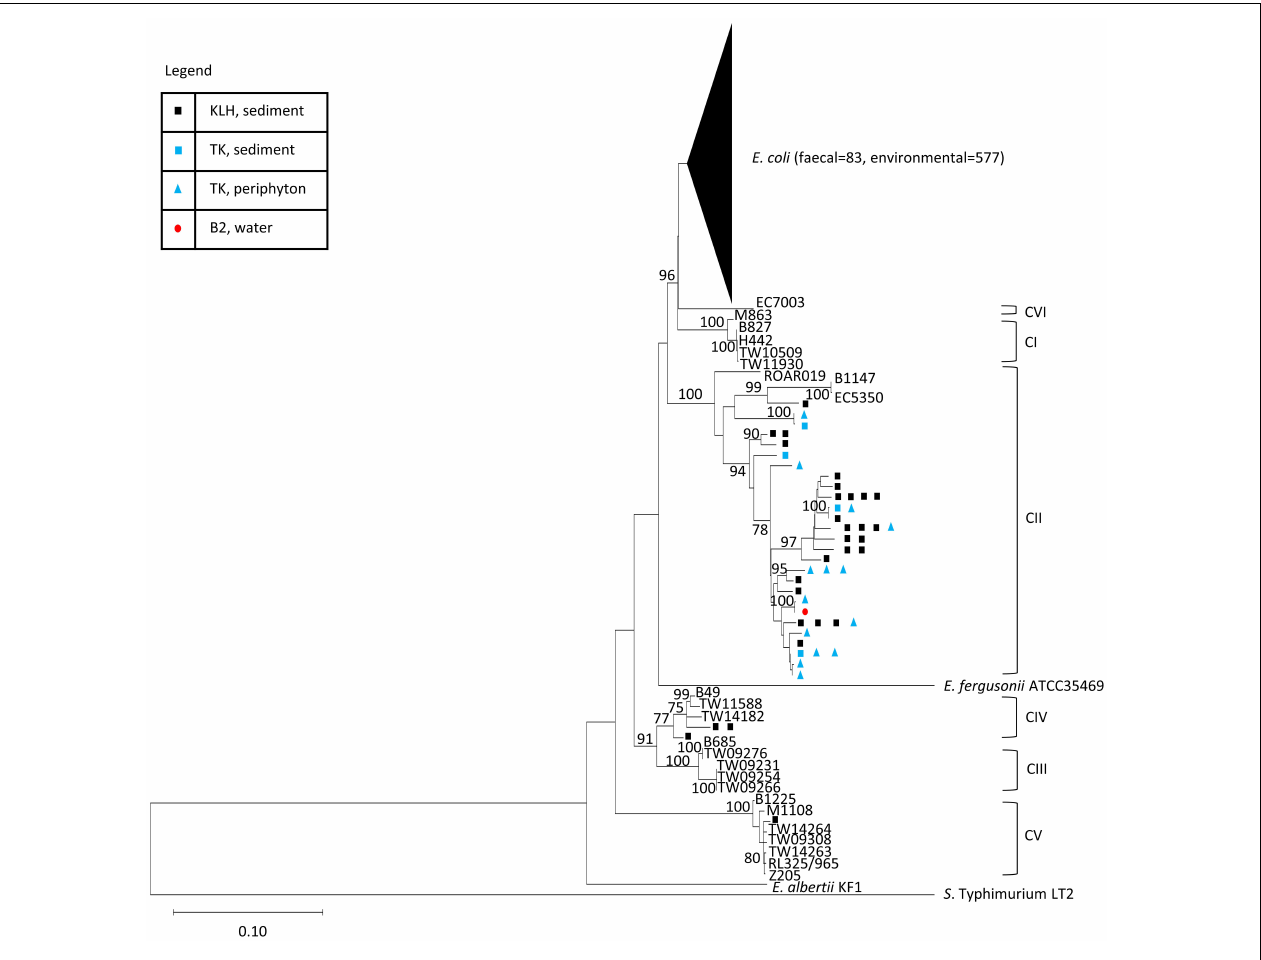
FIGURE 1 | Phylogenetic position of the isolates in study in reference to strains of Escherichia spp. reported in previous studies. ML tree was built using concatenated sequences of seven MLST loci from the isolates and reference strains (general time reversible G + I model, 500 bootstrap replications). Bootstrap supports > 75% are indicated at the nodes. The genetic cluster containing all E. coli was collapsed (size of triangle not proportionate to number of entries) for ease of visualization of the whole tree. Each sequence type of the isolates was represented once. S. enterica Typhimurium LT2 was used as an outgroup and the reference strains for the cryptic clades were indicated. Complete tree containing all entries (708 isolates and 105 references) were presented in Figure 2 . The isolation sources of the cryptic clades in this study were indicated at their respective terminal